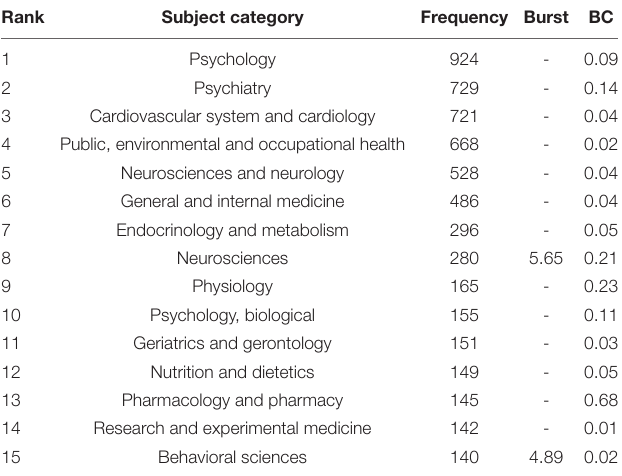
The focus population in bi-heart disease is people caring for people with dementia, who are at higher risk for CVDs and should be paid attention to (27).